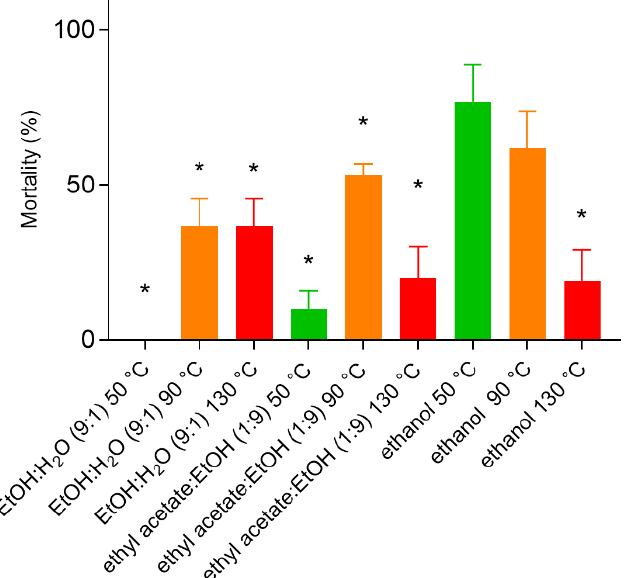
Figure 2. Aedes aegypti L3 larvae mortality after 24 h exposure to different Piper nigrum extracts (1.9 µg/mL). EtOH: ethanol; H2O: distilled water. * Significant statistical difference ( p < 0.05) when compared to 50 °C-prepared ethanolic extract by one-way ANOVA and Dunnett’s post hoc test. After variable determination (solvent and temperature), the factorial design experi- ments were executed, with yield and activity against Aedes aegypti L3 larvae (1.9 µ g/mL) recorded (Table S1, Supplementary Material). A total of 15 extractions (in duplicate)